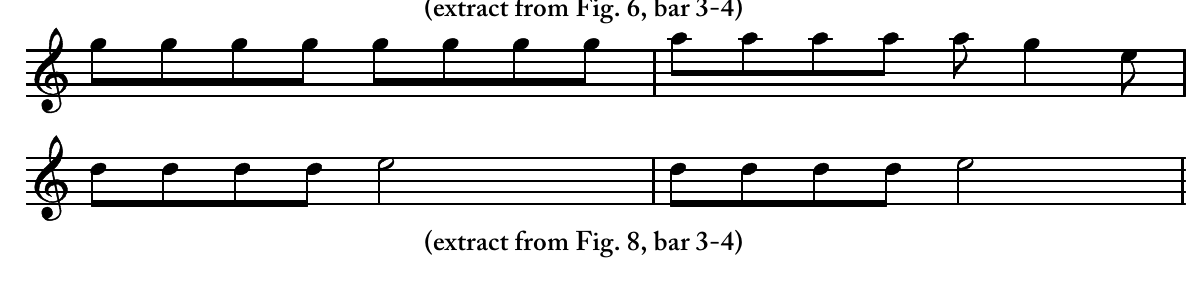
Fig. 9: melodic variation on the basis of harmonic equivalence (extract from Fig. 6, bar 3-4)